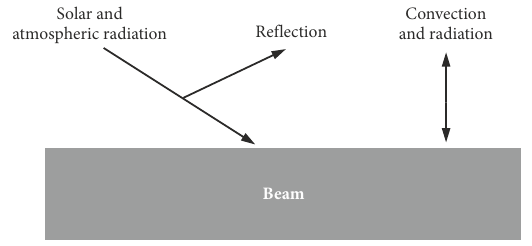
Solar and atmospheric radiation